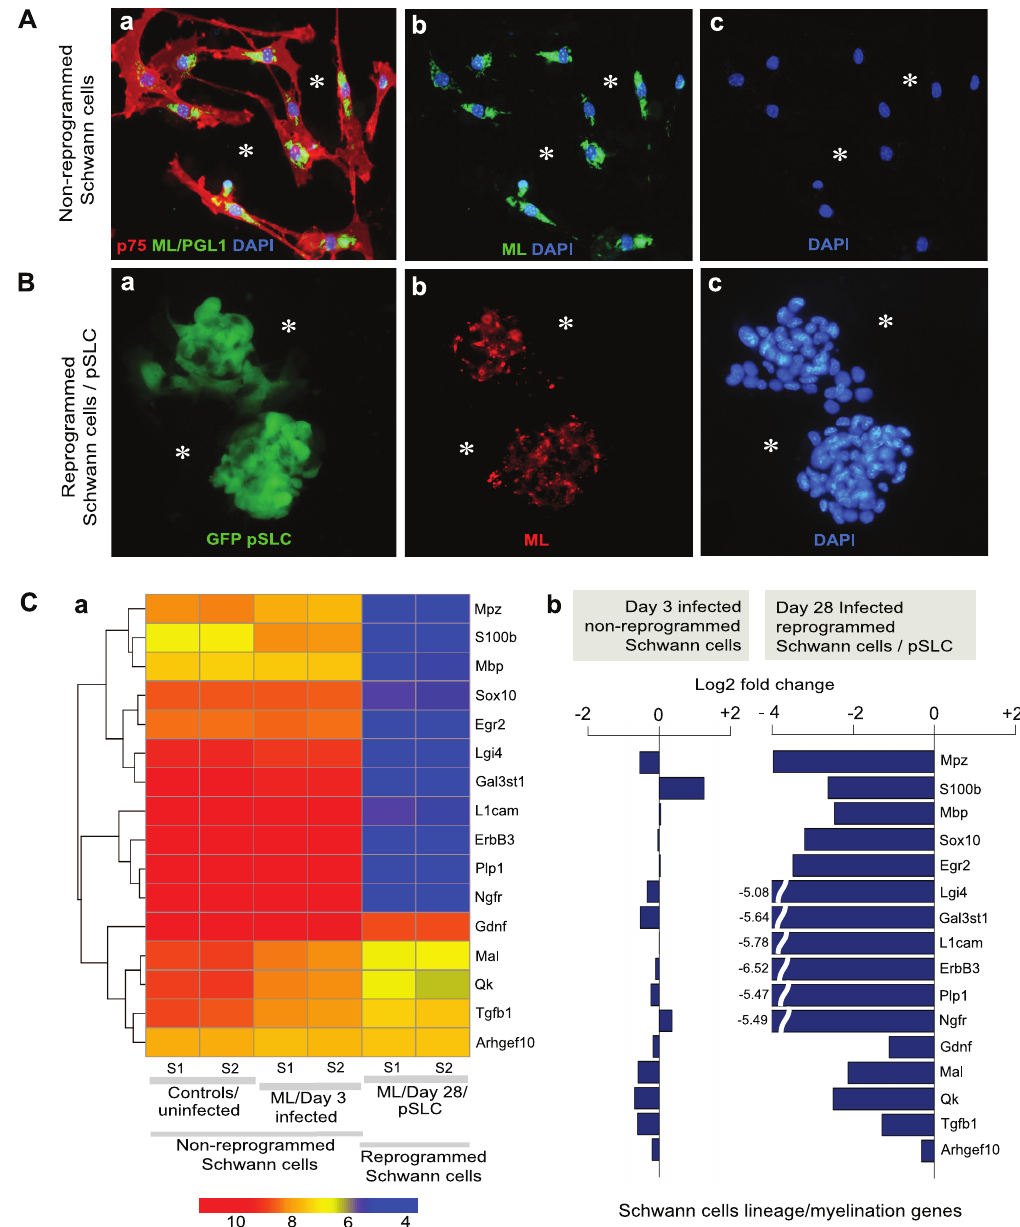
Figure 2. Properties of ML infected non-reprogrammed and reprogrammed Schwann cells. ( A ) Purified adult de-differentiated Schwann cells infected with ML for 3 days and labelled with antibodies to p75NTR (red) and ML-specific PGL-1 (green), counterstained with DAPI for nuclei (blue). ( B ) GFP pSCL (green) derived from day 28 infected Schwann cells labeled with anti-PGL1 and counterstained with DAPI (blue). Asterisks denote the absence of ML outside infected cells; ML strictly retain within the cytoplasm and no evidence of bacterial leakage to the surrounding when maintain as monocultures. Magnification: ( A - a , b , c to B - a , b , c ) 20x. ( C ) ( a ) Expression levels of known Schwann cell lineage/myelination genes, inferred by mRNA detection by Affymetrix Mouse microarray, from 2 samples (S1 and S2) each from control/uninfected Schwann cells, infected Schwann cells for 3 days (non-reprogrammed cells preserving Schwann cell identity) and pSLC-derived cells from day 28-infected Schwann cells (reprogrammed cells with loss of Schwann cell identity). Genes are clustered by Euclidean distance and average linkage for clarity. ( b ) Differential expression (log2 fold change) of known Schwann cell lineage markers, shown as relative to control for both day 3 infected cells (left) and 28-day-derived pSLC-state cells (right). The mean of both replicates for each of the three time points was used when calculating log2 fold change relative to control. Note that both absolute ( a ) and differentially expressed ( b ) patterns show a high degree of similarity between control/uninfected and day 3-infected cells, as compared to marked downregulation of Schwann lineage/in pSLC. Robust Multichip Average (RMA) values representing, on a logarithmic scale (base 2), the relative abundance of an mRNA transcript for a given gene, shown as a colour scale from highest (around 10) to lowest (around 4). Colour scale for heatmap ranges between minimum and maximum detection of selected genes, while full array’s range was 2.4 to